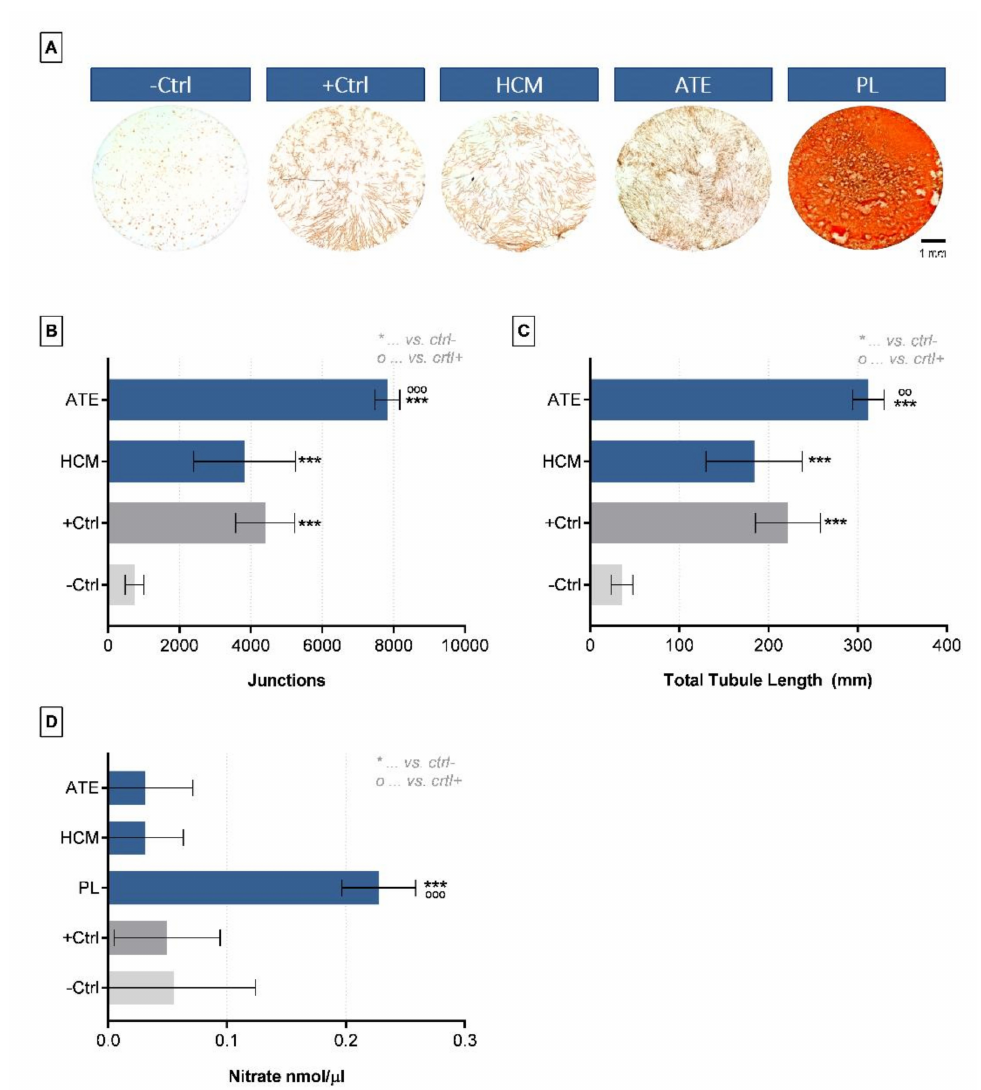
Figure 4. Angiogenic potential of growth factor mixtures as analyzed by a co-culture of osteogenically induced BM-MSCs and HUVECs. ( A ) Light microscopic images of tubular structures (visualized by CD31 immunostaining) after 10 days of cultivation in co-culture medium with di ff erent growth factor mixtures, ( B ) number of junctions, ( C ) total tubule length and ( D ) nitrate concentration (mean ± SD, n = 3; ◦◦ p < 0.01, *** / ◦◦◦ p < 0.001). -Ctrl: only co-culture medium, + Ctrl: co-culture medium + 20 ng / mL